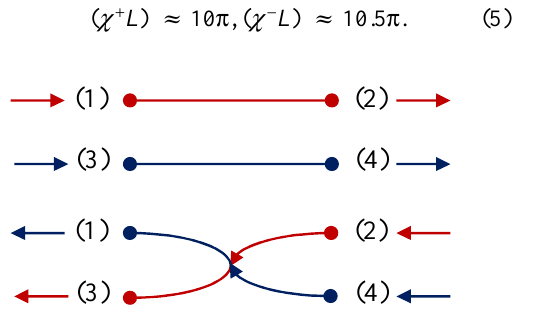
Fig. 3. Illustration of high-contrast non-reciprocity: the material parameters of the coupler can be adjusted in such a way that, for a given operating wavelength, the structure works as a perfect